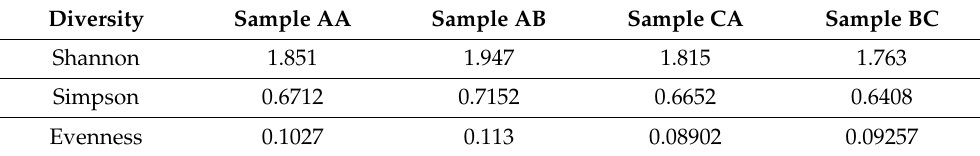
Table 2. Diversity indices of functional categories in both the rhizosphere and bulk soil samples.